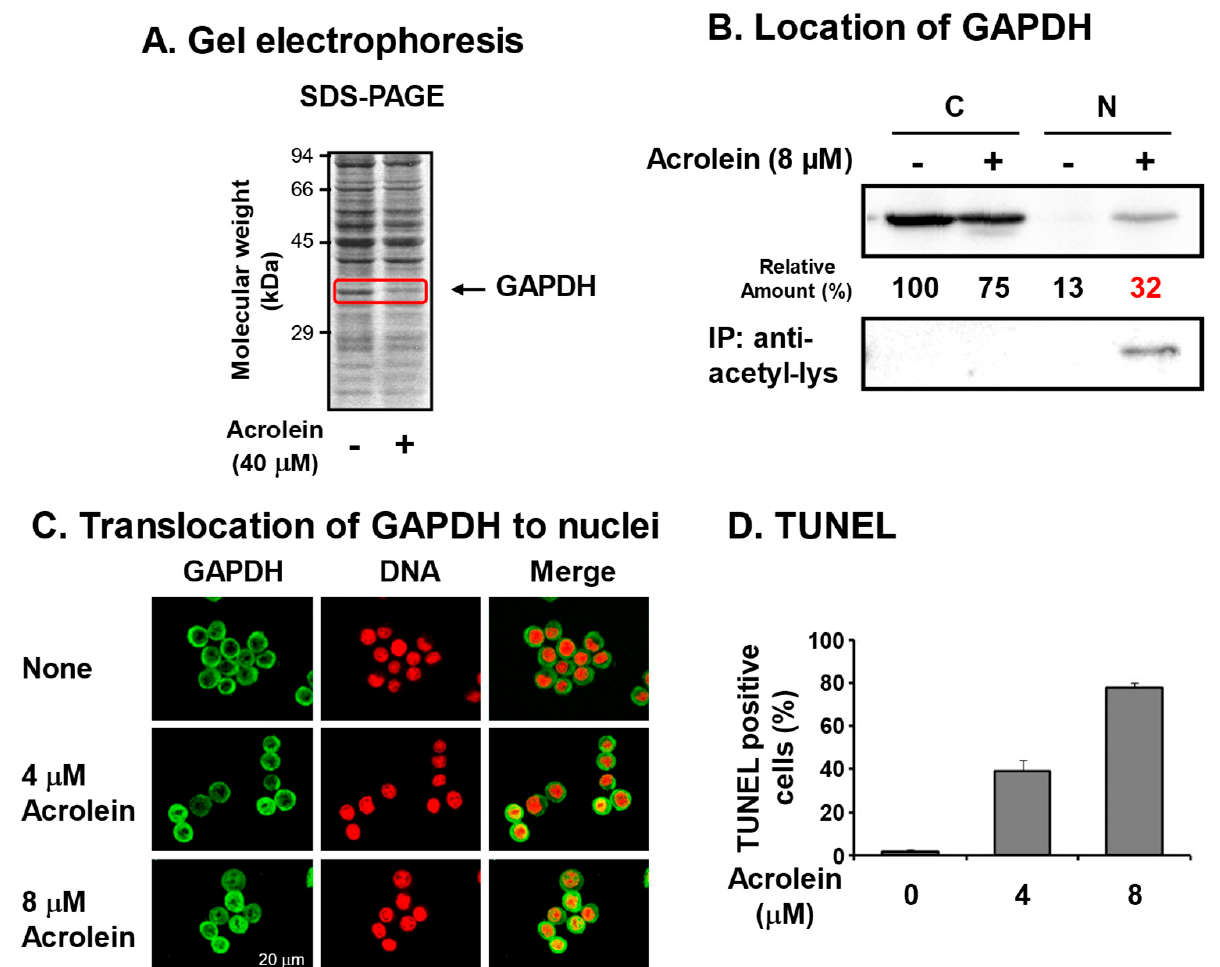
Figure 2. Identification of glyceraldehyde-3-phosphate dehydrogenase (GAPDH) as an acrolein- conjugated protein. ( A ). Identification of GAPDH as a reduced protein by acrolein treatment at 40 µ M for 9 h in S100 fraction of FM3A cells by gel electrophoresis. ( B ). Nuclear localization of acrolein-conjugated GAPDH in an acetylated form. FM3A cells were treated with 0 or 8 µ M acrolein for 6 h, and cytoplasm and nuclei were isolated. GAPDH and immunoprecipitated GAPDH by anti-acetyl-lysine in each fraction were identified by Western blotting. C, cytoplasmic fraction; N, nuclear fraction [28]. ( C ). Immunocytochemical detection of cells treated with 0, 4, and 8 µ M acrolein for 6 h using GAPDH antibody and staining of DNA with propidium iodide. Images were merged using a confocal microscope. Bar indicates 20 µ m. ( D ). The percentage of TUNEL-positive cells was indicated by counting approximately 500 cells. Values are means ± S. E. of triplicate determinations. Adapted with permission from Ref. [28]. 2013 Elsevier.